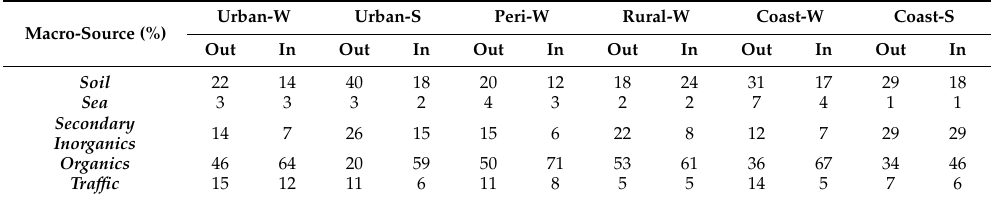
Table 3. Outdoor and indoor particulate matter (PM) composition expressed in terms of the five macro-sources average contribution (in %).